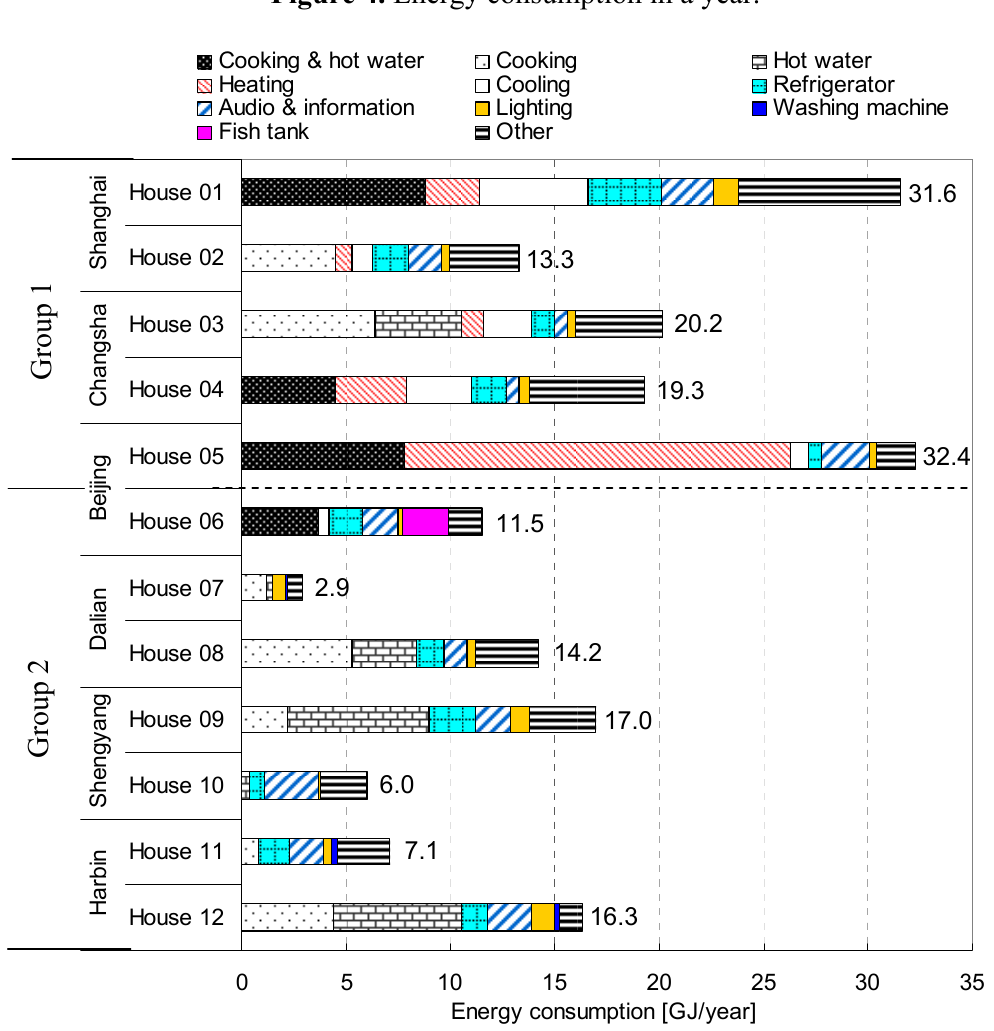
Figure 4. Energy consumption in a